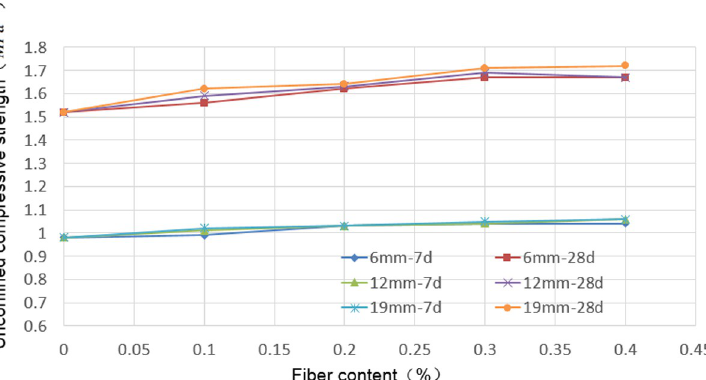
Fig 7. Unconfined compressive strength of fiber stabilized carbide slag solidified soil. For the same fiber length and content, the unconfined compressive strength of the solidified soil significantly increased with increasing curing time. For each group of fibers, the 7 and 28 d unconfined compressive strength increased with increasing fiber content, but the degree of improvement was limited.